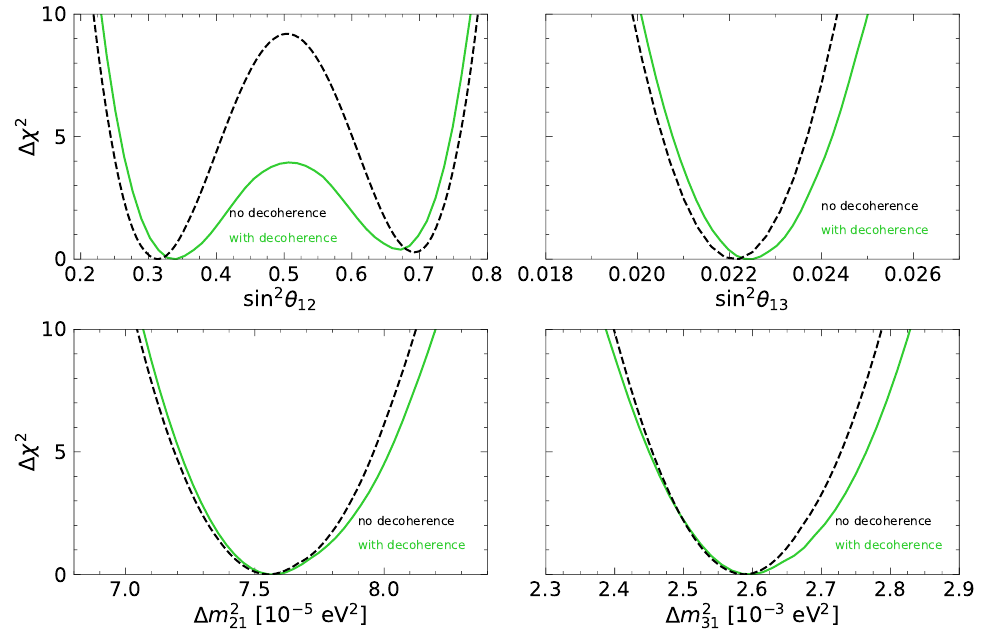
Figure 2 . The reduced χ 2 profiles as a function of the standard neutrino oscillation parameters, obtained from the combined analysis RENO + Daya Bay + KamLAND including decoherence effects (green, solid) and assuming a perfectly coherent source (black, dashed). The profiles are calculated with respect to the global minimum for each case.